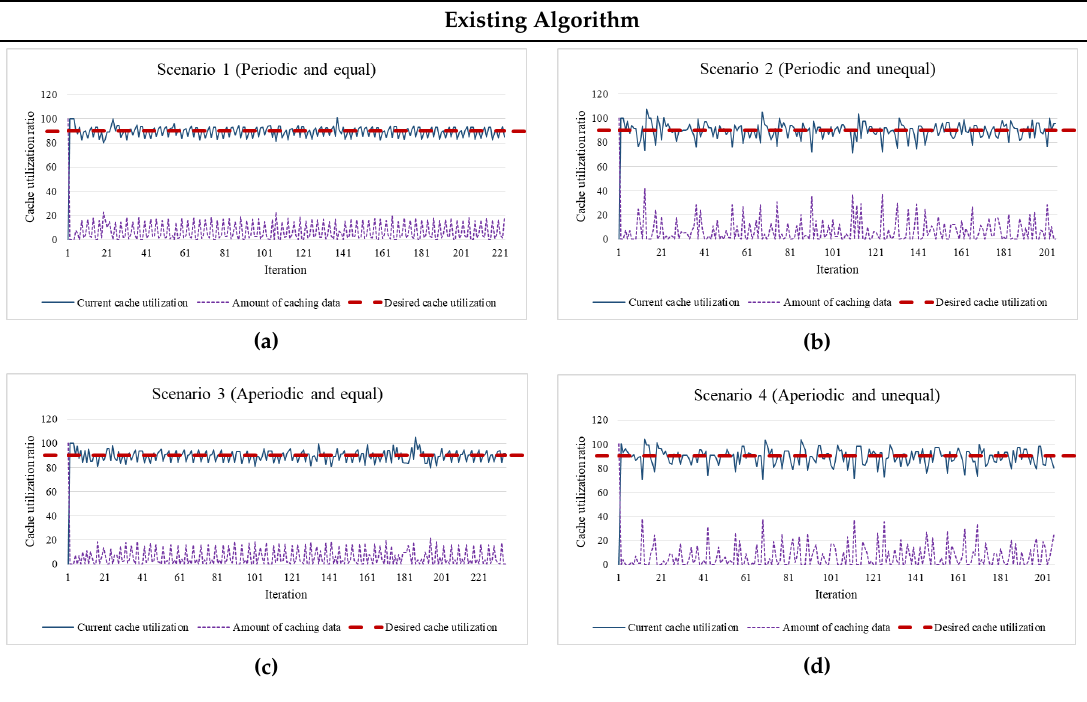
Table 4. Representative performance evaluation results of existing algorithm.